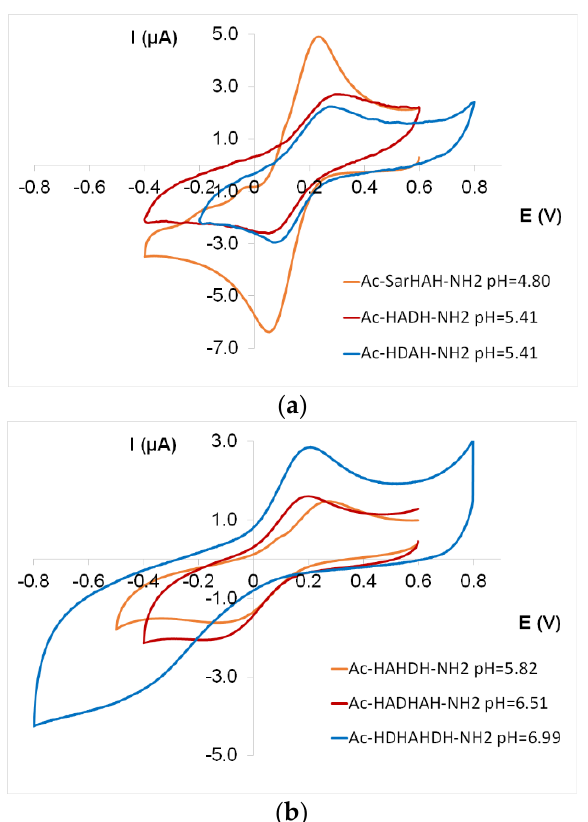
Figure 8. Cyclic voltammogram of [CuL] complex of two histidine-containing tetrapeptides (Ac-SarHAH-NH 2 , Ac-HADH-NH 2 , Ac-HDAH-NH 2 ) ( a ) and three histidine-containing penta-, hexa- and heptapeptides (Ac-HAHDH-NH 2 , Ac-HADHAH-NH 2 , Ac-HDHAHDH-NH 2 ) ( b ). However, a more significant difference can be observed in the case of copper(II) com- plexes coordinated by the [N Im ,N − ,N − ,N Im ] donor set (Figure 9b). The redox potential of the [CuH − 2 L] complex of aspartic acid-containing peptides is increased compared to the pre- viously studied peptides. Studies of Cu(II) complexes with different type of ligands have shown that the rigid structure of the Cu(II) complex cannot satisfy the coordination requirement of Cu(I). This explains that copper(II) complexes with quasi-square planar geometry ([NH 2 ,N − ,N − ,N − ] coordinated species of oligopeptides, [NH 2 ,N − ,N − ,N Im ] coordinated complex of GGH pep- tide, [N − ,N − ,N − ,N Im ] coordinated complexes of terminally protected histidine-containing peptides) have low (negative) redox potential values. The reduction process of Cu(II) com- plexes has been proved to be facilitated when the Cu species can easily evolve towards a tetrahedral geometry upon reduction, which increases the stability of Cu(I) complex [28– 33]. Based on these facts, the redox potential values fall in the positive range due to the distorted geometry of the [CuH − 2 L] complex of multihistidine peptides, and the geometry of the complex is further distorted by the interaction between the metal centre and the carboxylate group of aspartic acid.